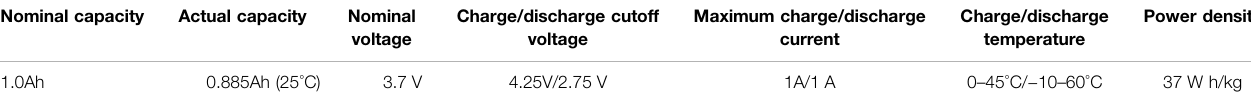
TABLE 1 | Basic parameters of the tested battery cell.